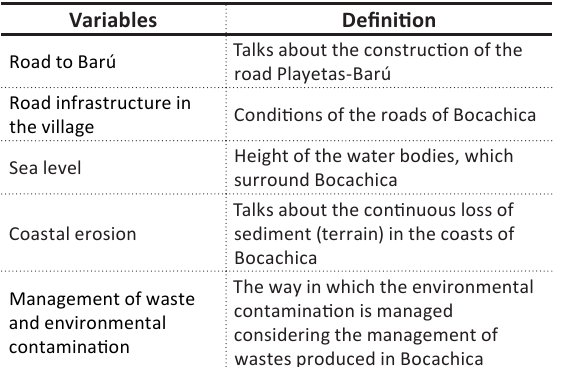
Table 5. Environmental dimension Source: Elaborated by the authors.